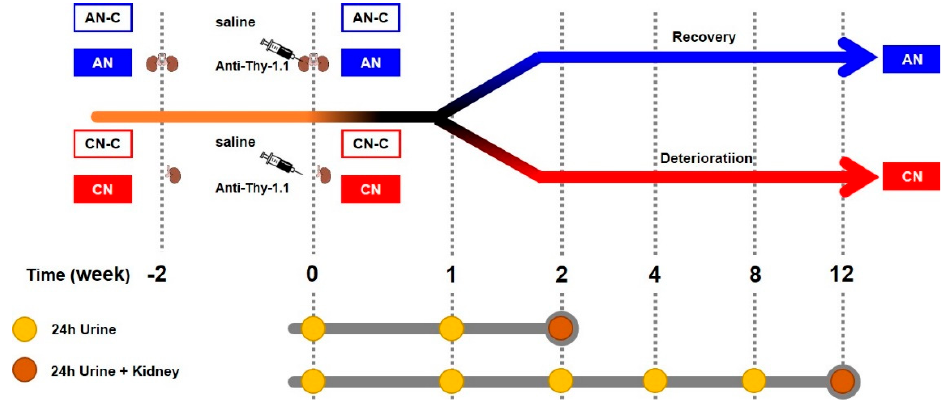
Figure 2. Experimental design of the nephritis rat model. The AN animals were produced via the injection of mouse anti-Thy1.1 antibody. The CN group was induced through the administration of the mouse anti-Thy1.1 antibody to unilaterally nephrectomized rats. AN, acute nephritis; AN-C, control group for acute nephritis; CN, chronic nephritis; CN-C, control group for chronic nephritis.